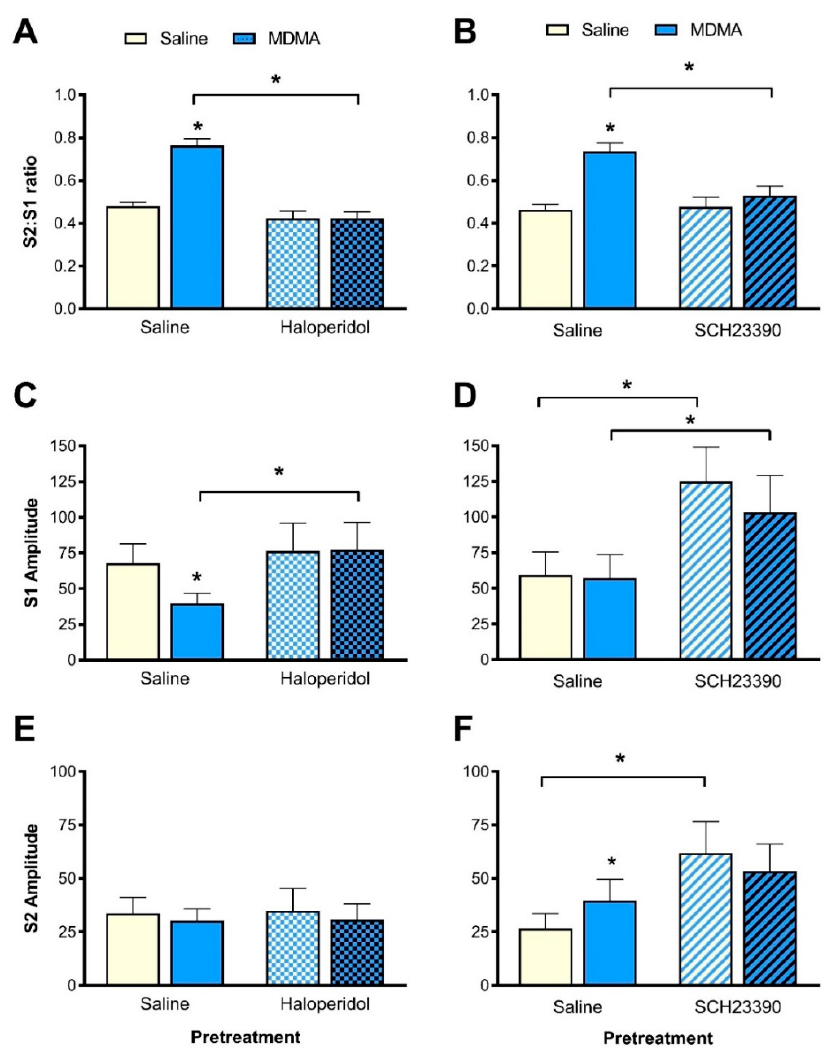
Figure 3. E ff ect of haloperidol ( A , C , E ) or SCH23390 ( B , D , F ) on MDMA-induced disruption of auditory sensory gating. ( A , B ) MDMA increased the S2:S1 ratio, an e ff ect that was blocked by haloperidol and SCH23390 pretreatment, respectively. ( C ) MDMA treatment reduced the S1 amplitude and pretreatment with haloperidol prevented this e ff ect. ( D ) SCH23390 pretreatment increased S1 amplitude for both saline and MDMA treatments. ( E ) S2 amplitudes remained una ff ected by MDMA and haloperidol. ( F ) MDMA slightly increased S2 amplitude in the saline pretreatment condition. SCH23390 pretreatment prevented this e ff ect and increased S2 amplitude. Data are mean ± standard error of the mean (SEM). * denotes significance at p < 0.05. N = 10 and 8, respectively.